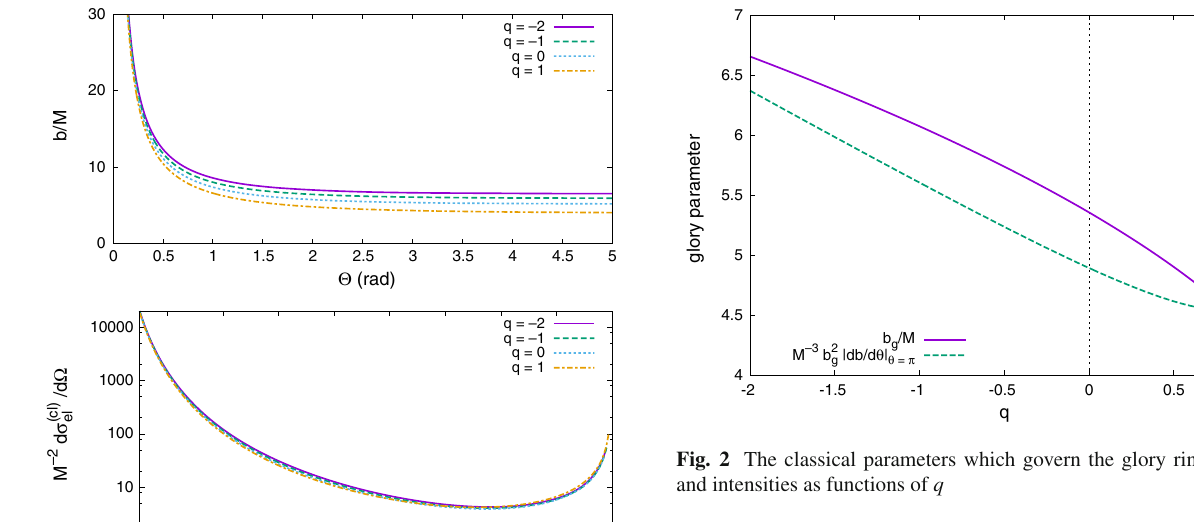
now h b ( u ) admits two negative roots for b > b c , while in the